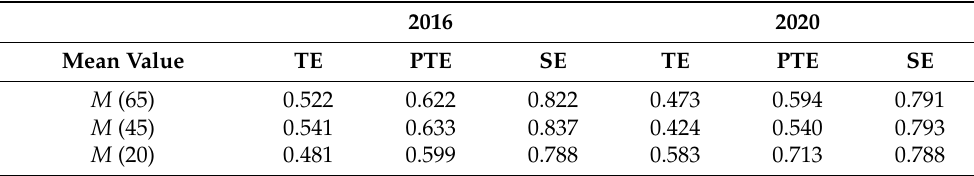
Figure 1. Average efficiency of the retail enterprises.